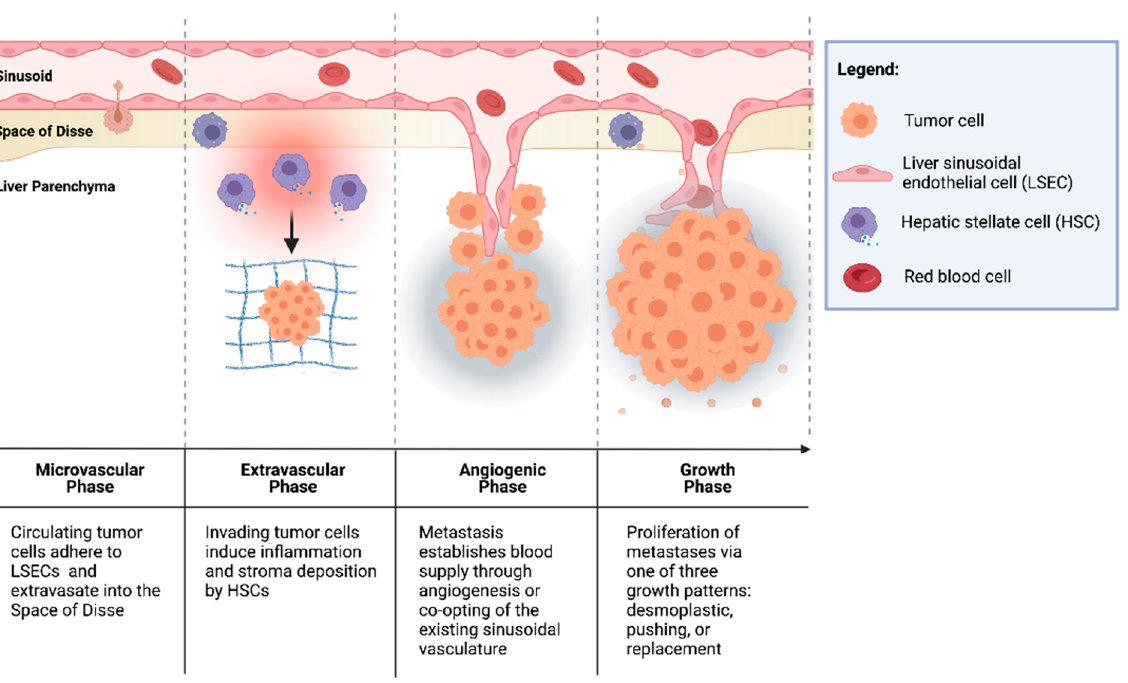
Figure 1. Formation of colorectal liver metastases through four overlapping phases: microvascular, extravascular, angiogenic, and growth.